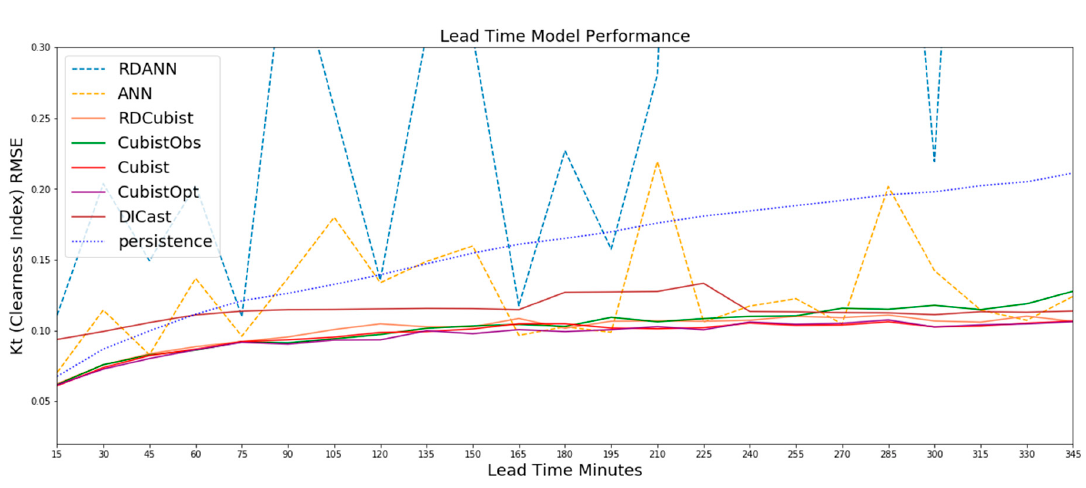
Figure A1. The results on the test dataset for all methods show that the Cubist-based methods (solid color lines) all perform considerably better with lower RMSE than the other methods with the CubistOpt method having a small improvement over the other Cubist methods. The ANN based approaches (dashed lines), especially the RD-ANN method, performs the worst on nearly all lead times.